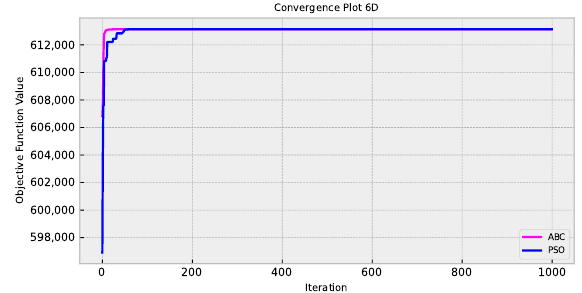
Figure 6. Convergence plot for 6D at 10 m/s mean wind speed.